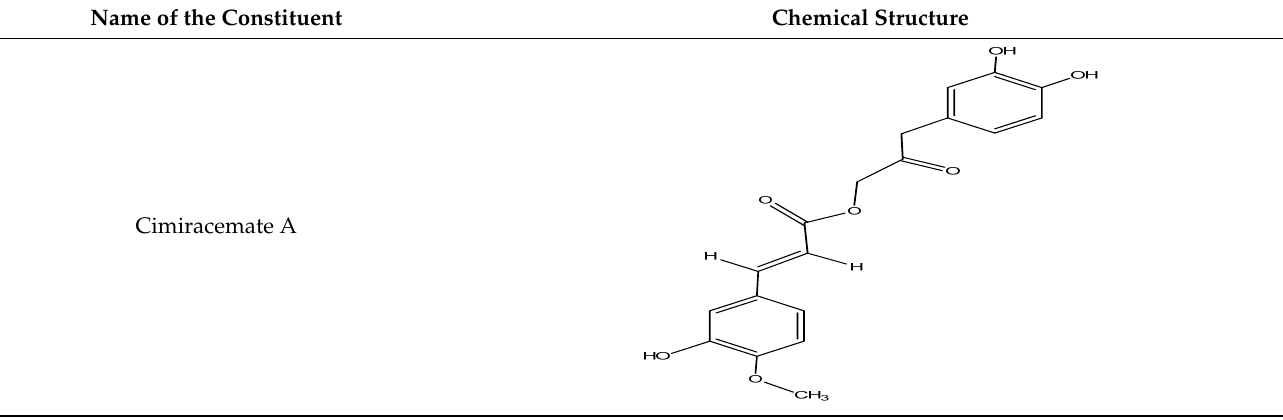
Table 4. Chemical structures of important constituents present in CR.